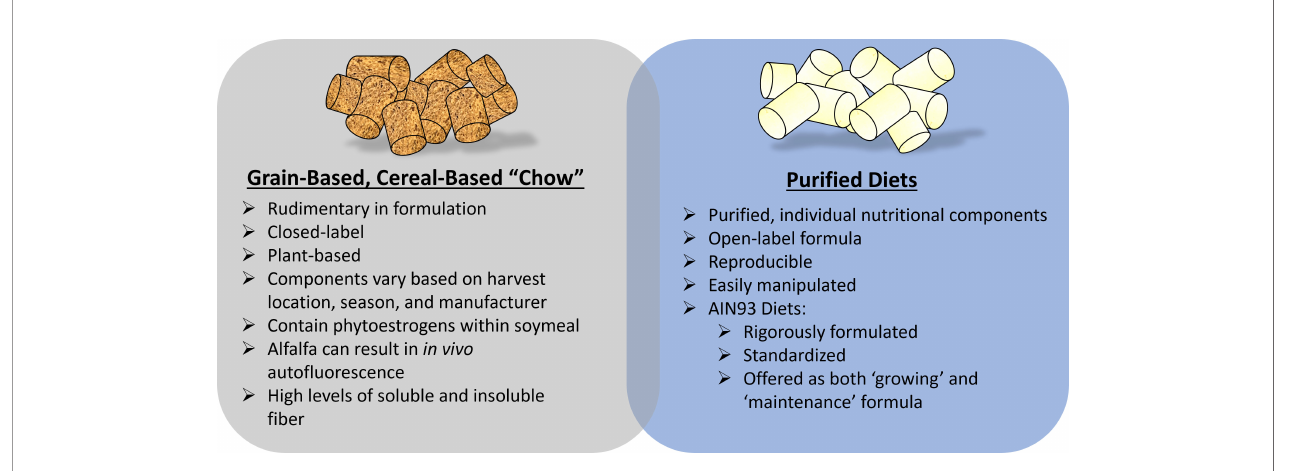
FIGURE 2 | Key dietary considerations when using preclinical rodent models to study osteoporosis-related research. Fundamentally, considerations related to grain- based, chow diets versus a puri fi ed diet are important. A hybrid of these diets (chow mixed with puri fi ed ingredients) is often discouraged unless critical for study